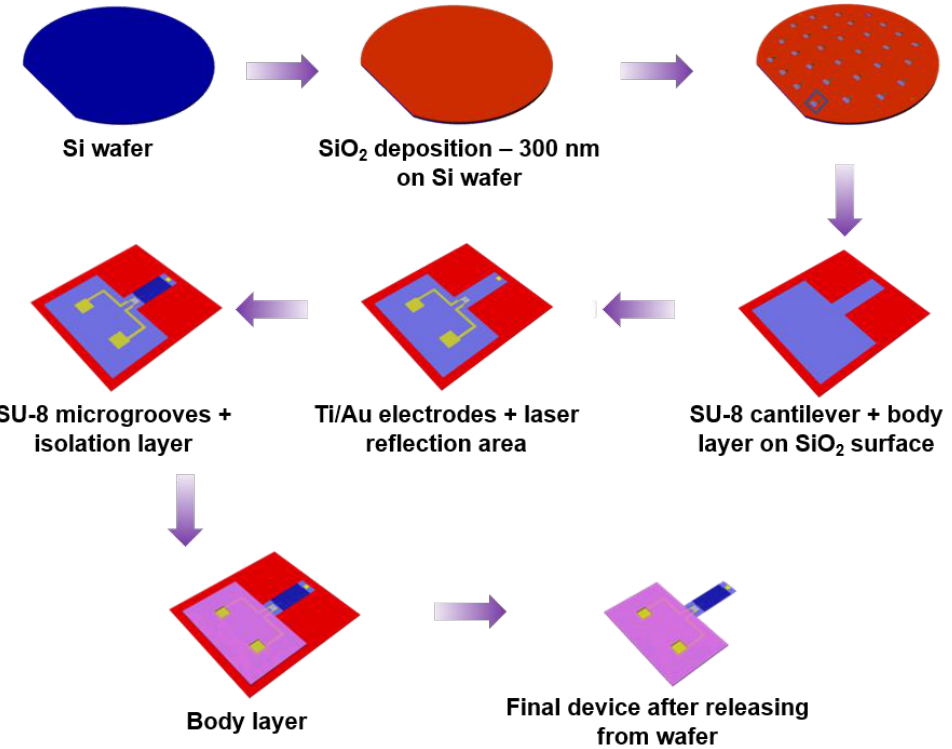
Figure 2. Fabrication process flow of the dual function device.